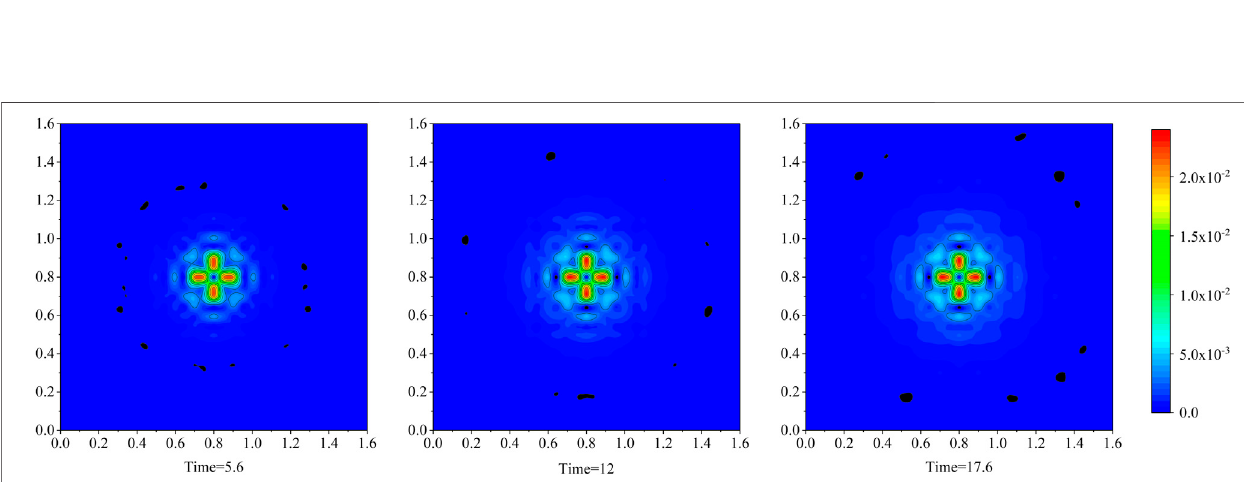
FIGURE 2 | Comparison of temperature fi elds between numerical solution and fi ne solution at different times.